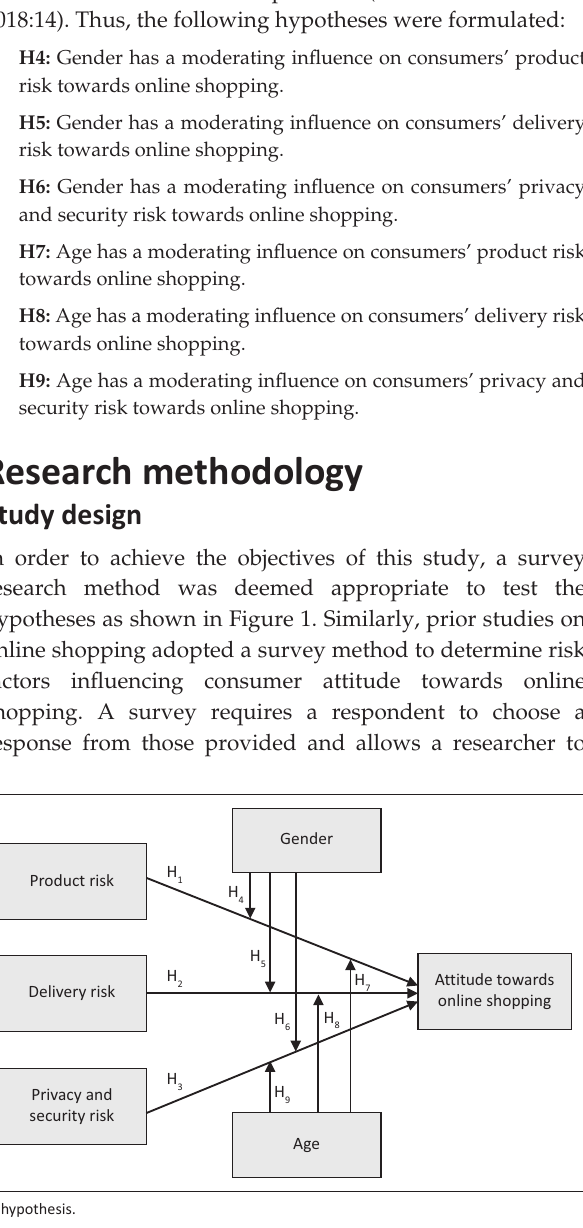
FIGURE 1 : Perceived risks